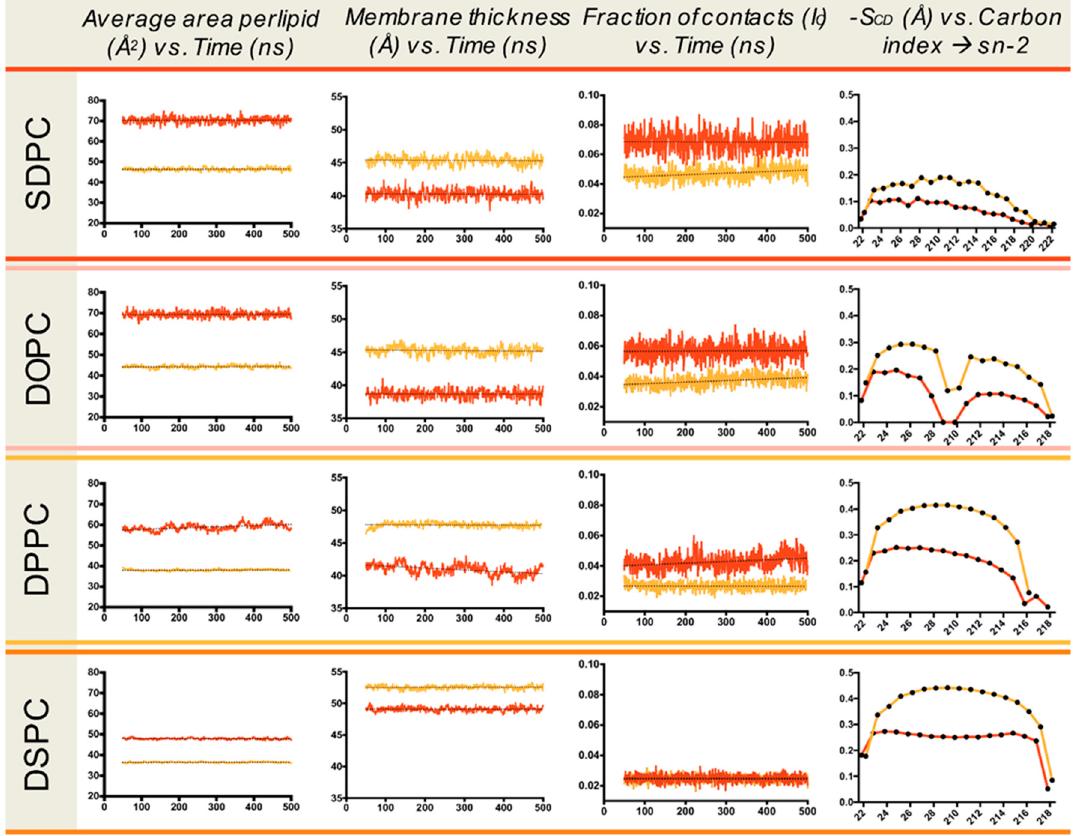
Figure 7. MD simulation of membrane local properties—impact of cholesterol. Averaged properties for each lipid species with (33%; orange line) and without cholesterol (red line). S CD order parameters, membrane thickness, lipid interdigitation, and area per lipid were obtained using MEMBPLUGIN